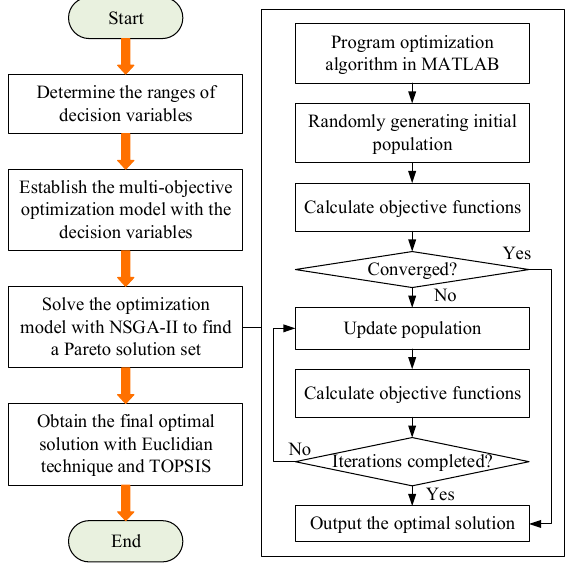
Figure 2. Solution procedure for the multi-objective optimization problem.